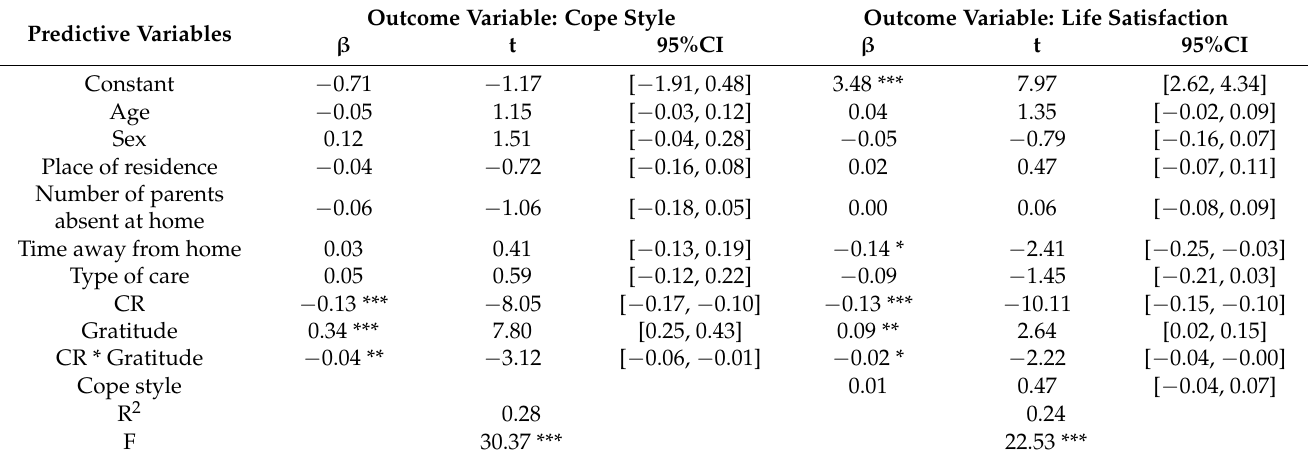
Table 3. Test for moderating mediating effects of CR on life satisfaction.